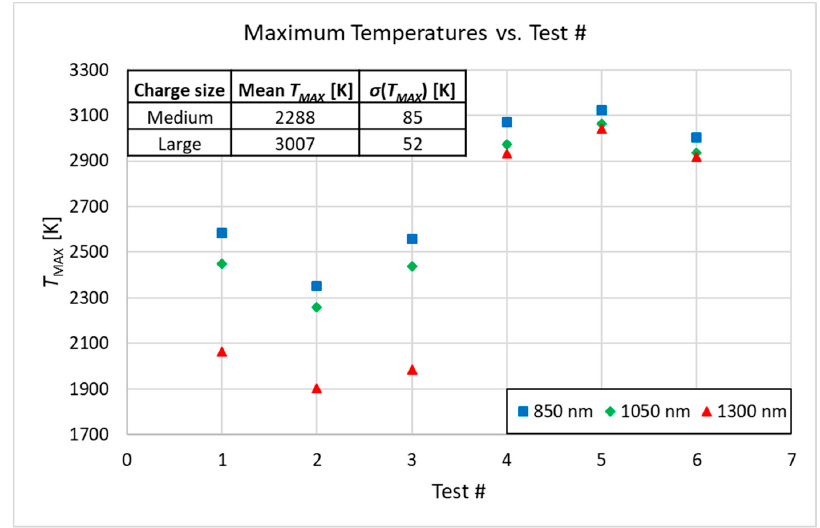
Figure 12. Plot of maximum temperatures versus test number. The inset on the upper left shows some statistics: Mean T MAX and σ ( T MAX ) are, respectively, the average and the standard deviation of peak temperatures measured at different λ .